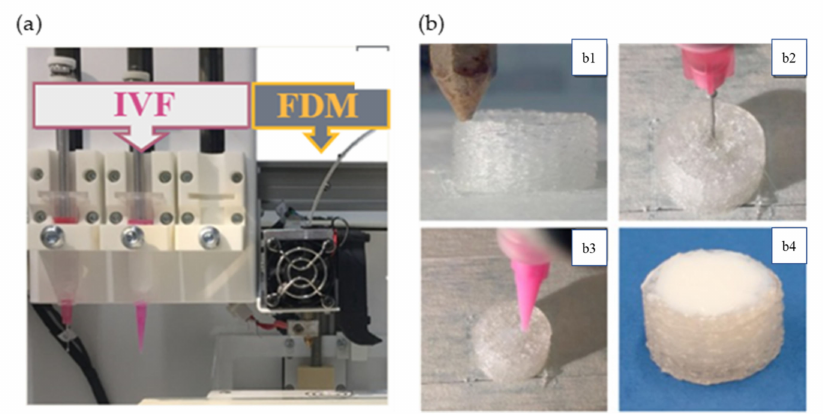
Figure 11. ( a ) Integration of FDM with IVF and ( b ) ( b1 ) extruder of FDM technology. ( b2 ) Syringe of IVF technology injecting the drug-loaded gel. ( b3 ) Syringe of IVF technology injecting the delaying release polymer. ( b4 ) Obtained images of final printfill of the tablets. Images reproduced with per-mission from [99]. Copyright Elsevier,